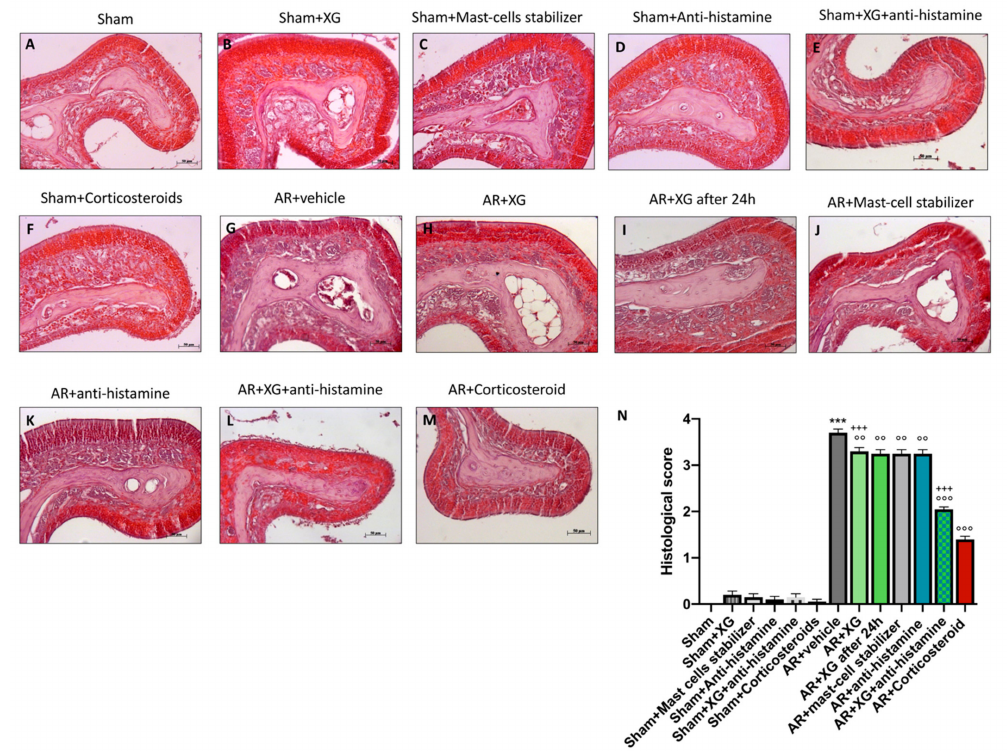
Figure 7. Effect of XG treatment on histological evaluation of nasal mucosa. OVA-challenged nasal mucosa showed edema and tissue inflammation ( G , histological score N ) compared to the sham groups ( A – F , histological score N ). XG-based spray treatment significantly reduced tissue injury ( H , I , histological score N ); the reduction in OVA-tissue damage was also considerable in single treatments with mast cell stabilizer ( J , histological score N ) and antihistamine ( K , histological score N ). XG and antihistamine co-administration showed a meaningful protection in histological injury ( L , histological score N ) like corticosteroid group ( M , histological score N ). Data are representative of at least three independent experiments. Values are means ± SEM. One-Way ANOVA test. *** p < 0.001 vs. Sham; ◦◦ p < 0.01 vs. AR + vehicle; ◦◦◦ p < 0.001 vs. AR + vehicle; +++ p 0.001 vs. AR +